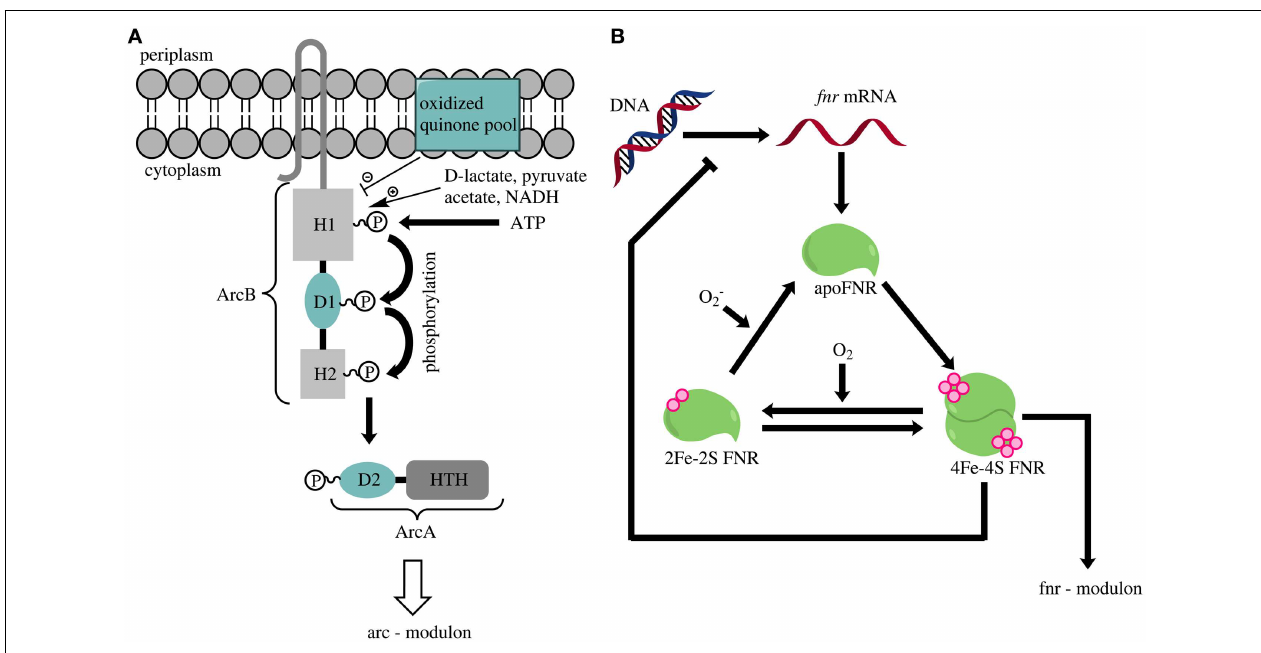
activation (according to and modified fromTolla and Savageau, 2010). Oxygen inactivates the active dimeric form of FNR that contains one 4Fe-4S-cluster per monomer (4Fe-4S FNR). Continuous production of new FNR molecules and reactivation of the inactive 2Fe-2S-form (2Fe-2S FNR) or the apoenzyme (apo FNR) leads to constant cycling of the three FNR-forms.The absence of oxygen triggers a rapid accumulation of the 4Fe-4S-form, which dimerizes and thereby becomes an active transcription